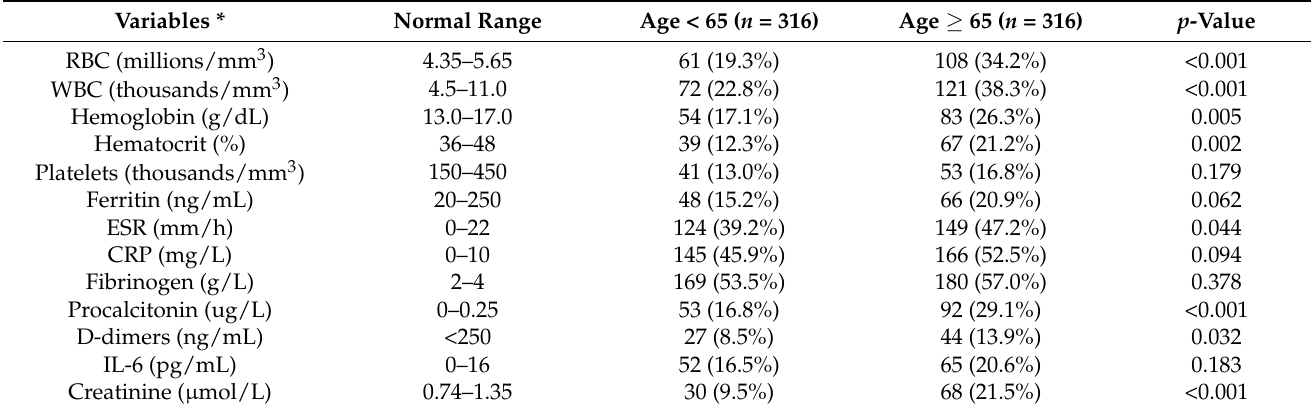
Table 2. Comparison of biological parameters during hospitalization between cases and controls.